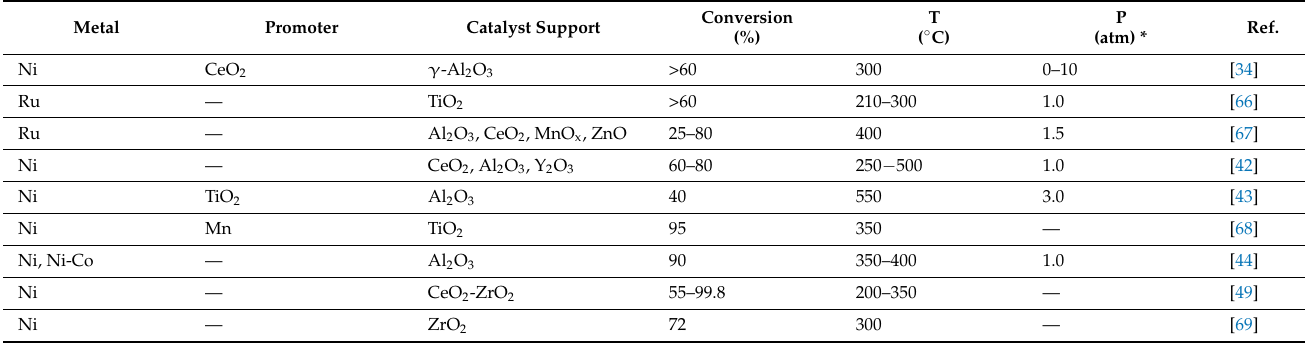
Table 2. A comparative summary of different metal-supported catalysts studied in the carbon dioxide methanation